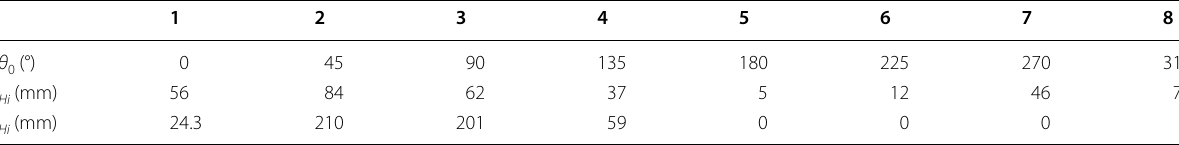
Table 1 Coordinates of pre-assigned points